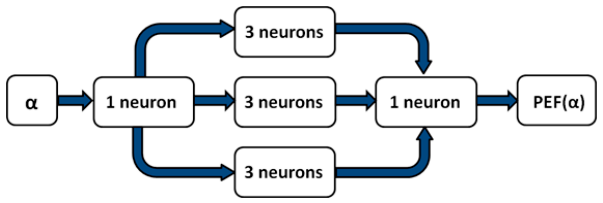
Figure 1. Construction of the neural network used for probe error modeling. α : probe deflection angle; PEF: Probe Error Function.